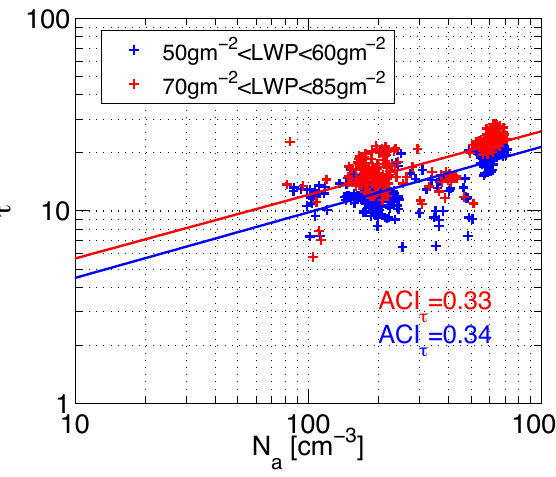
Figure 8: Scatterplot between N